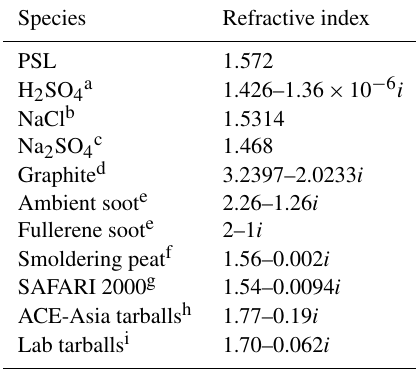
Table 1. Refractive indices near